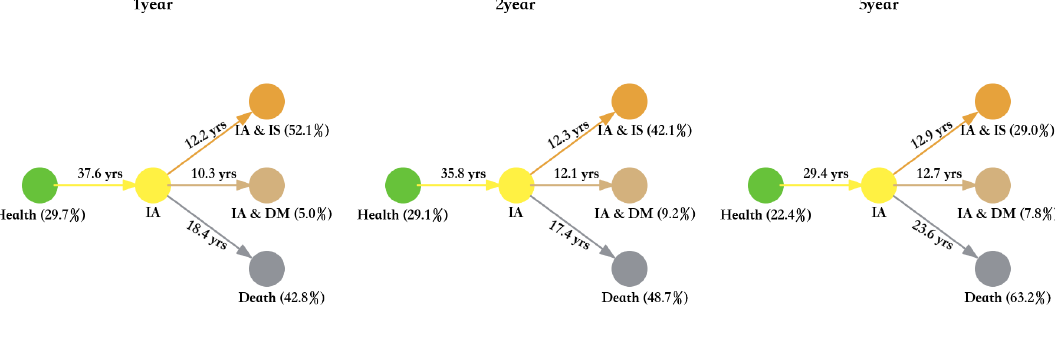
Figure 11. IA transition status for different time interval groups.